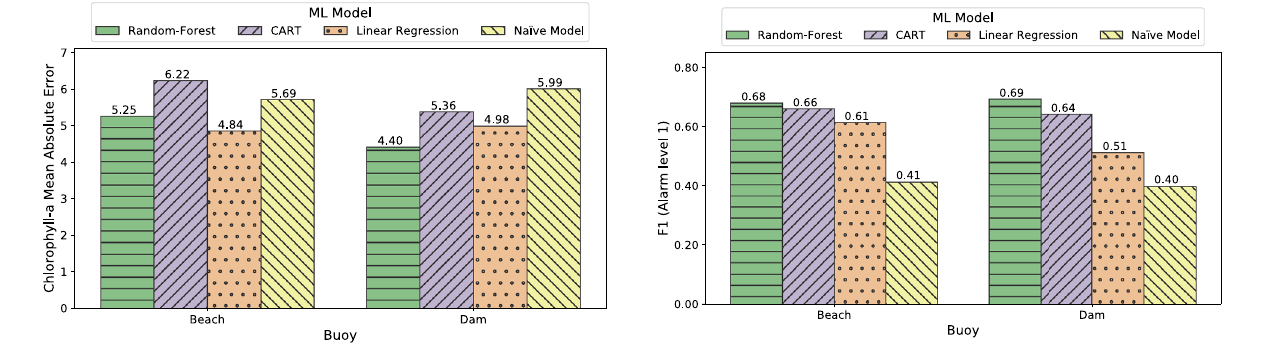
Figure 3. Comparison of the performance of ML models in Beach and Dam buoys. MAE calculated on ML-based soft sensors ( a ) and F1 calculated on alarm post-processing outputs ( b